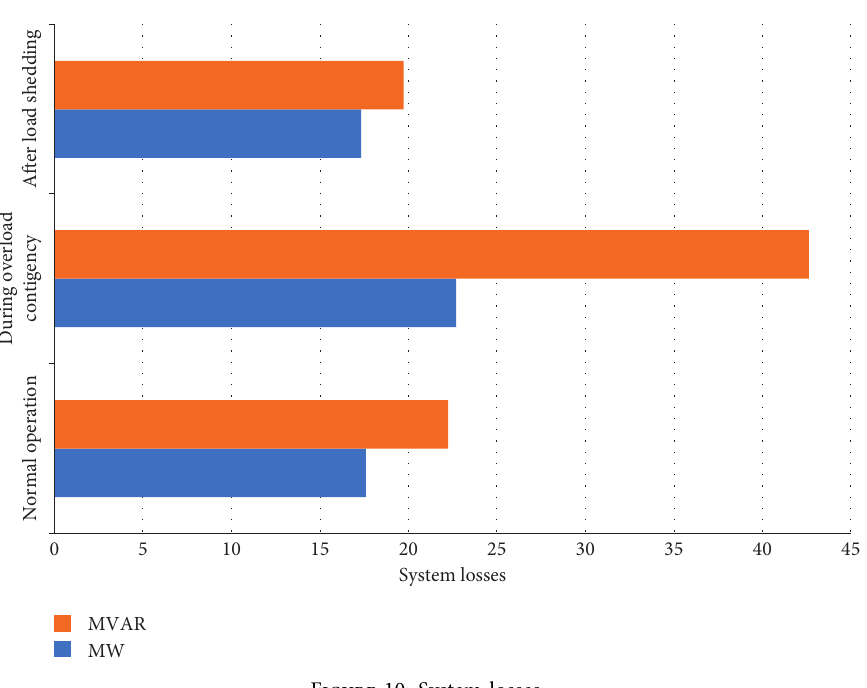
Figure 10: System